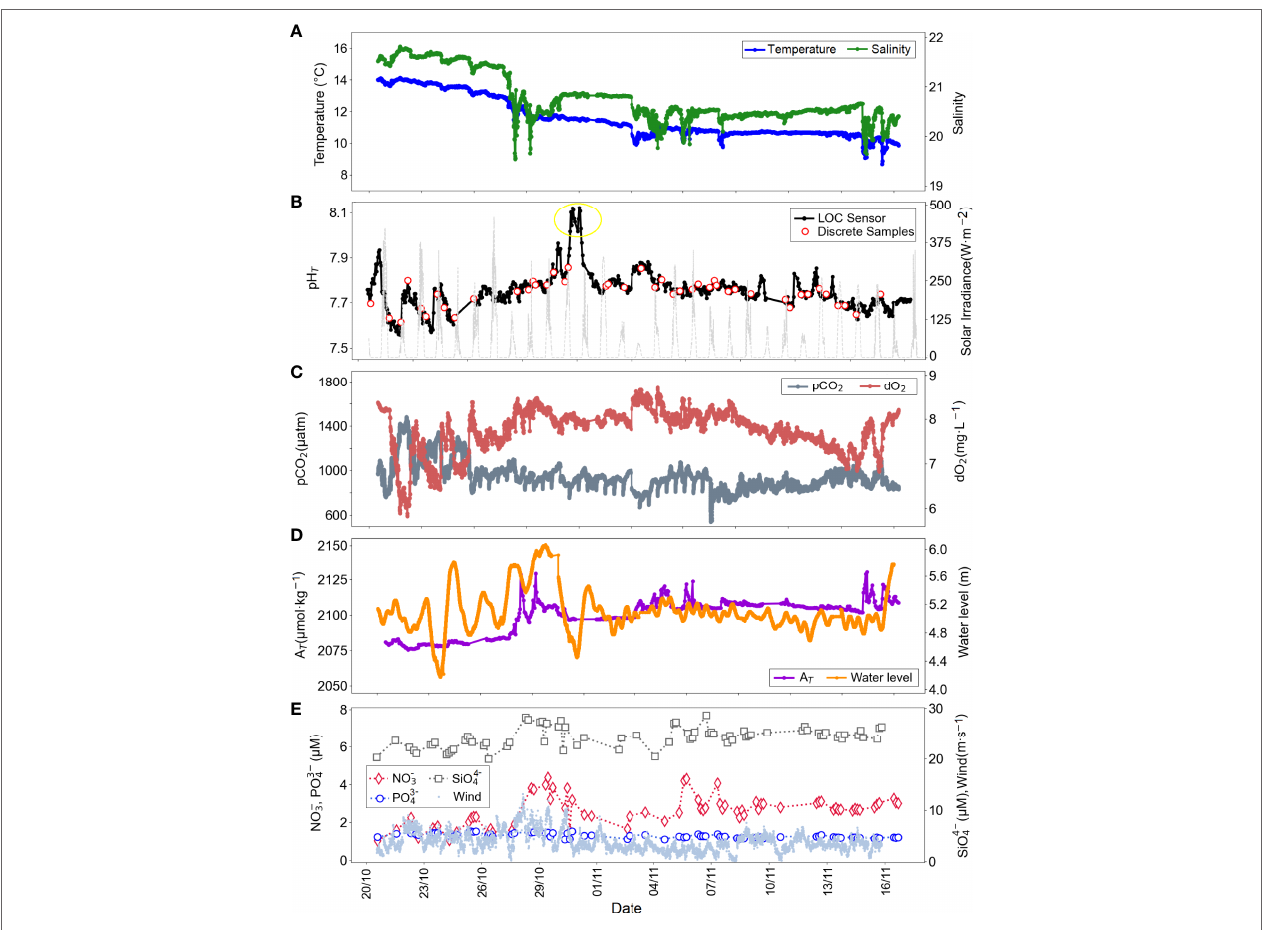
FIGURE 5 | Diel variations of (A) in situ temperature (blue), in situ salinity (green), (B) in situ pH T (black: LOC sensor, red circles: discrete water samples, yellow circle: outliers), solar irradiance (light grey), (C) in situ pCO 2 (dark grey), in situ dO 2 (coral), (D) salinity-derived A T (purple), water height (orange), and (E) NO 3- (red diamond), PO 43- , (blue circles), SiO 4-4 (grey squares), and wind speed (pale blue dots) with multiple sensors deployed at the GEOMAR pontoon in Kiel Fjord in autumn 2018, from October 20 to November